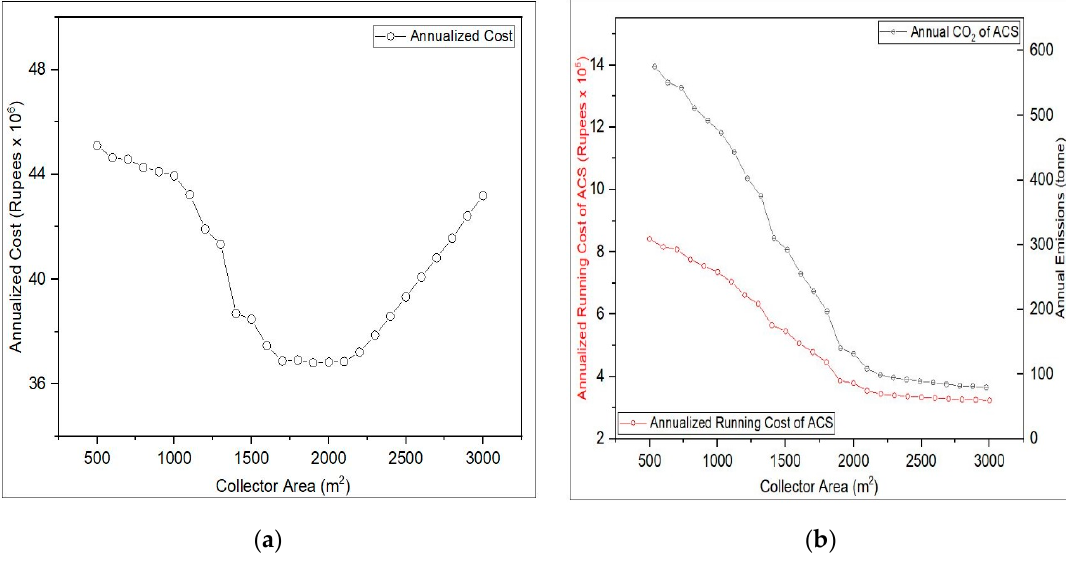
Figure 12. ( a ) Variation of annualized cost of ACS by varying collector area; ( b ) variation of annualized running cost and annual CO 2 emissions of ACS by varying collector area.